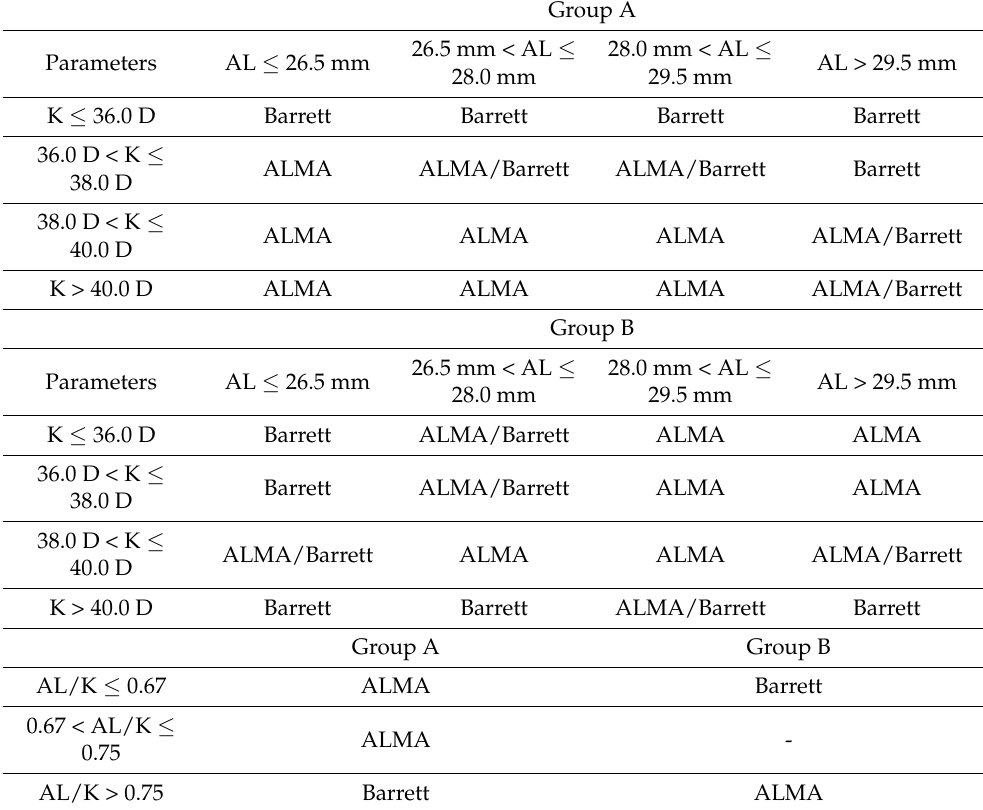
Table 5. Suggested formulas plotted by different mean keratometry (K) ranges and different axial length (AL) ranges. In case of two formulas have been suggested, AL/K could clarify which should be preferred. If the analysis of the AL/K parameter is inconclusive, it is possible to consider an average IOL power value between the two proposed